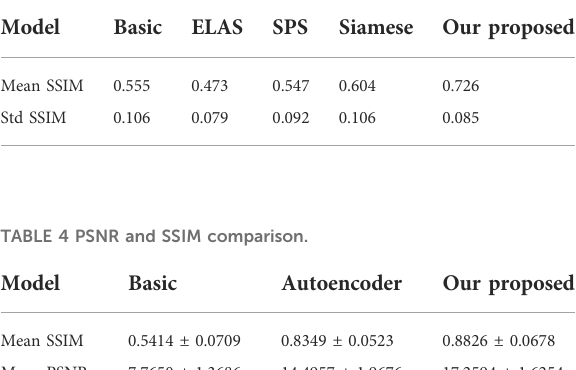
TABLE 5 MAE and RMSE